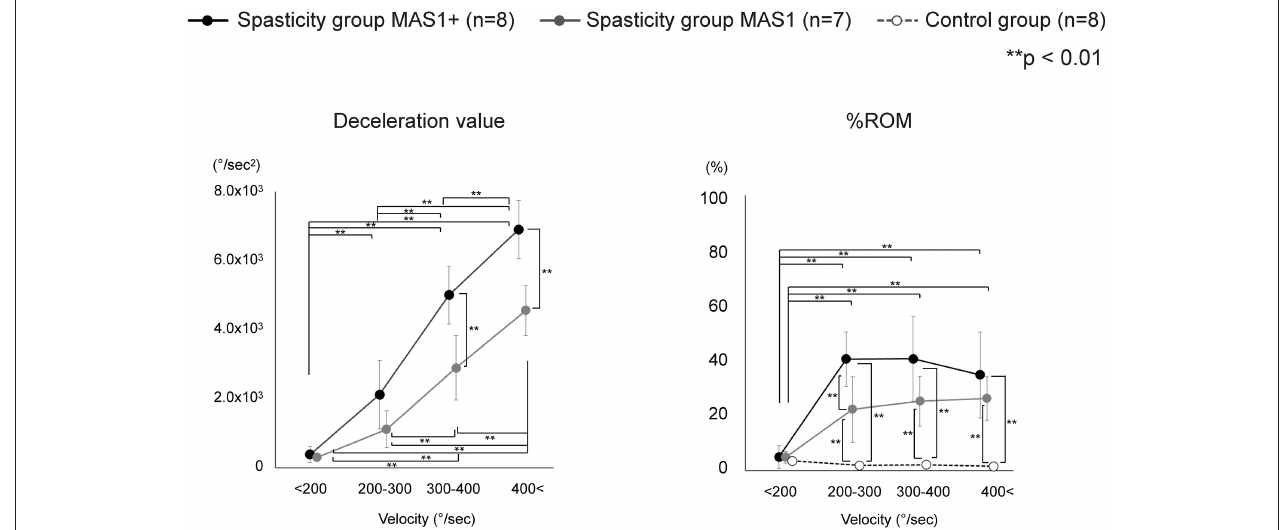
FIGURE 4 | Variation of each index value with change in velocity. Deceleration value increased with increasing velocity, and there was also a significant difference between MAS 1 + and MAS 1 above 300 ◦ /s conditions. Unlike deceleration value, the value of the %ROM difference between MAS 1 + and MAS 1 occurred only in 200–300 ◦ /s conditions and did not increase with an increase in the velocity. The %ROM of control was significantly lower than that of the spasticity groups.